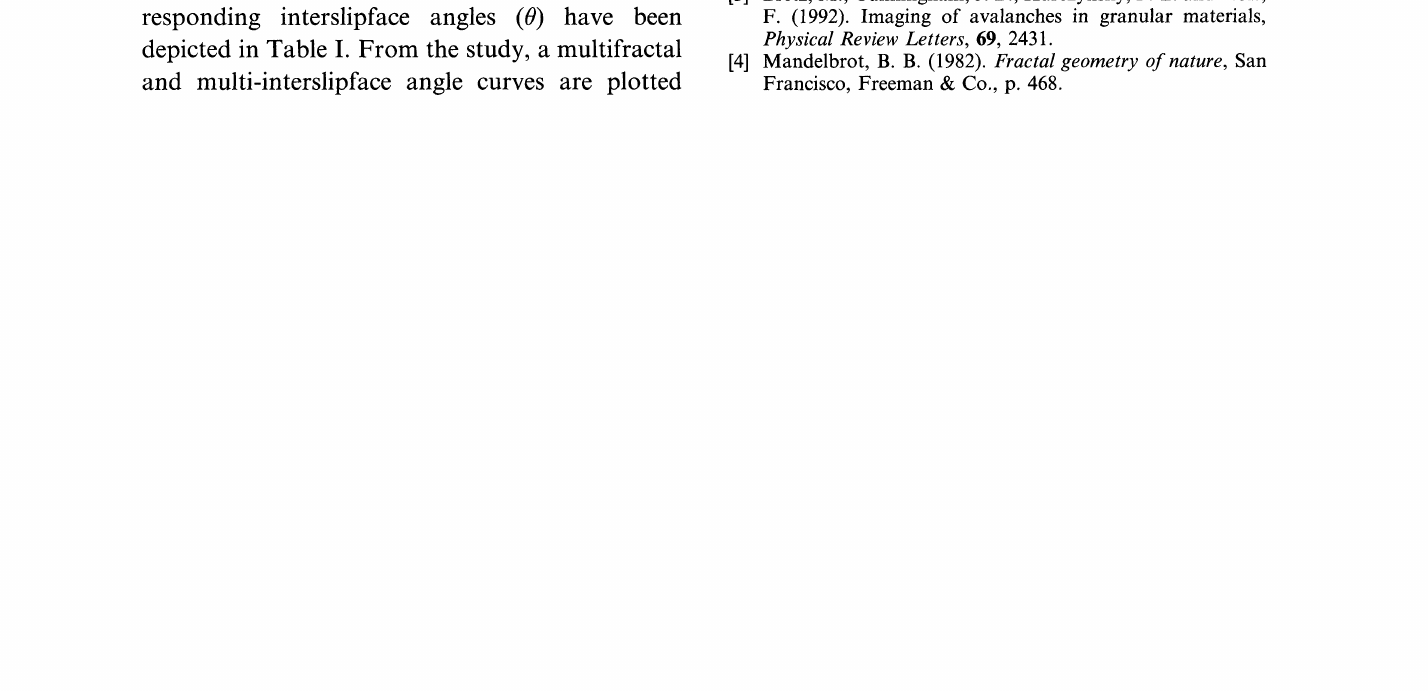
The computed fractal dimensions (D) and